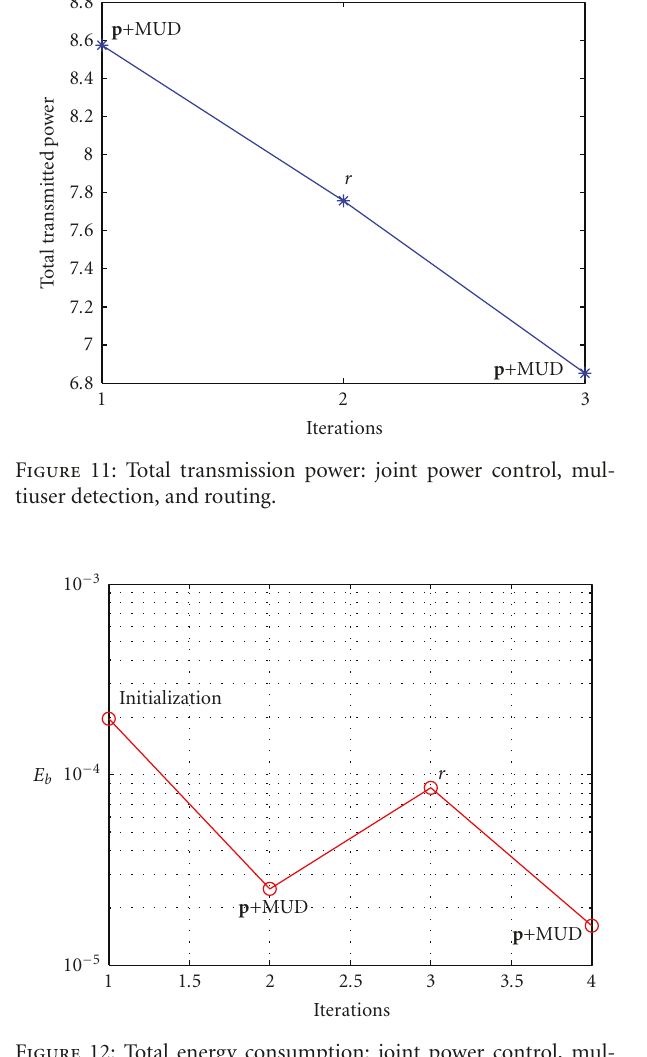
Figure 12: Total energy consumption: joint power control, mul- tiuser detection, and